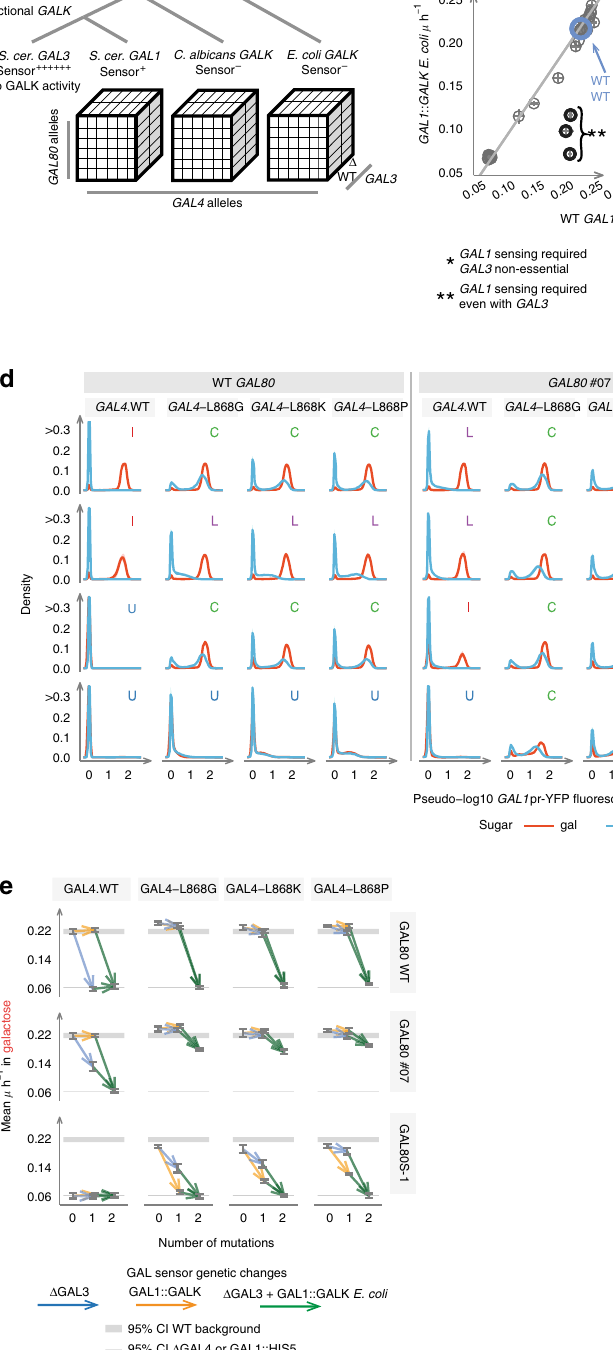
also retain the ability to interact with Gal1p and Gal3p to allow relief of repression in galactose media. Mechanistically, it is still not clear why this mutant background exhibits a higher dependency on GAL1 compared to GAL3 . For example, we did not observe this in other GAL80S + GAL4C pairings. Most other GAL80S variants showed abilities to repress GAL4C , however tended to exhibit more “ Constitutive ” or “ Uninducible ” characters, with similar degrees of activation in